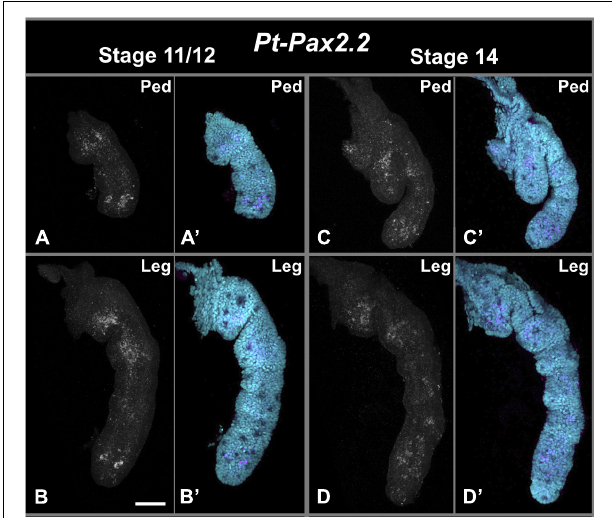
FIGURE 7 | Pt-Pax2.2 expression in pedipalps and walking legs during late embryogenesis. Panels on the left (A,A’,B,B’) show dissected prosomal appendages during inversion and/or retraction stage (stage 11/12). Right panels (C,C’,D,D’) show appendage preparations from ventral closure stage (stage 14). Upper panels (A,A’,C,C’) show Pt-Pax2.2 expression in dissected pedipalps (Ped), note most proximal region of the pedipalp was lost during dissection. Lower panels (B,B’,D,D’) show Pt-Pax2.2 expression in dissected walking legs. During inversion and retraction of the embryo Pt- Pax2.2 is expressed three region of the pedipalps and walking legs. While the proximal (missing for the pedipalp, please see Figure 4A ) and medial expression domain has a broad and more diffuse appearance, the expression in the distal tip of these prosomal appendages has a spot-like pattern. During later stages the expression fades and becomes even more diffuse also in the distal part. Cyan is nuclear DAPI staining; magenta is Pt-Pax2.2 specific expression detected with FAST RED. Scale bar represents 50 µ